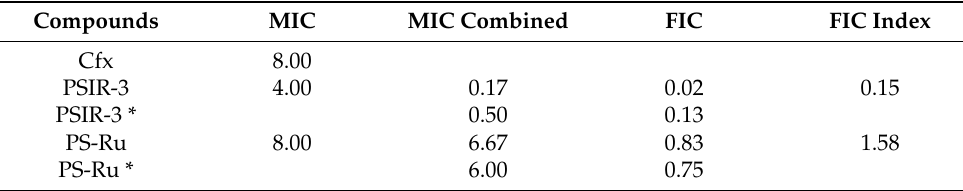
Table 4. Fractional inhibitory concentration (FIC) index